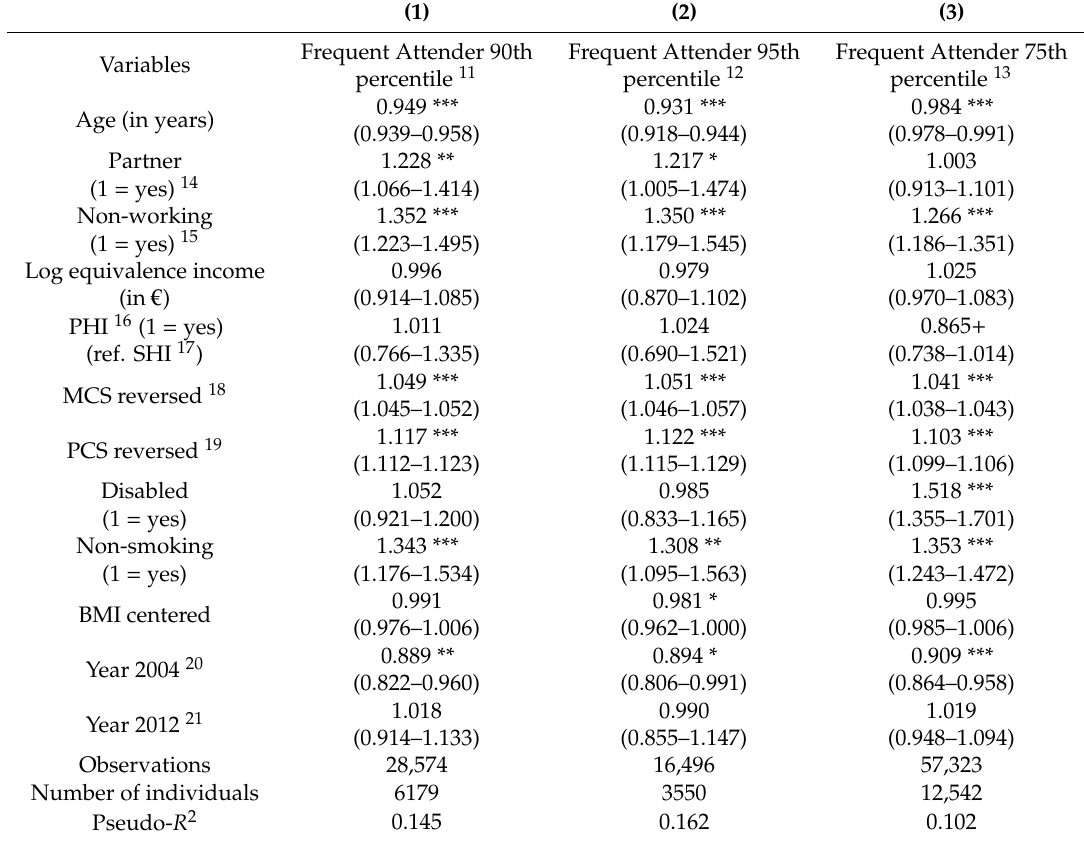
Table 2. Regression results GSOEP 2002–2014: frequent